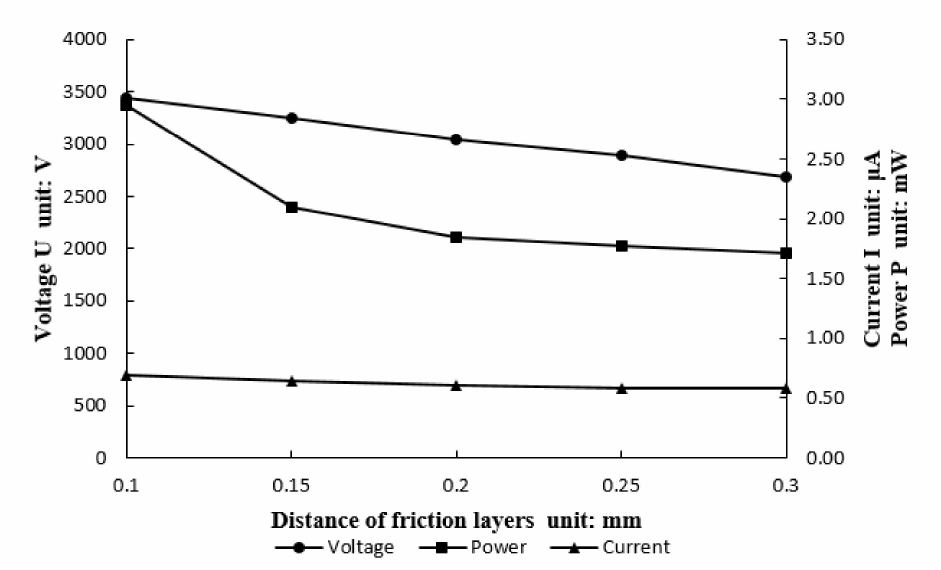
Figure 8. Peak power, current and voltage vary with distance.